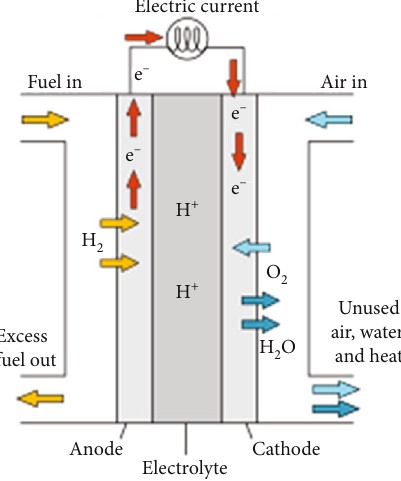
Figure 3: PEMFC-proton change